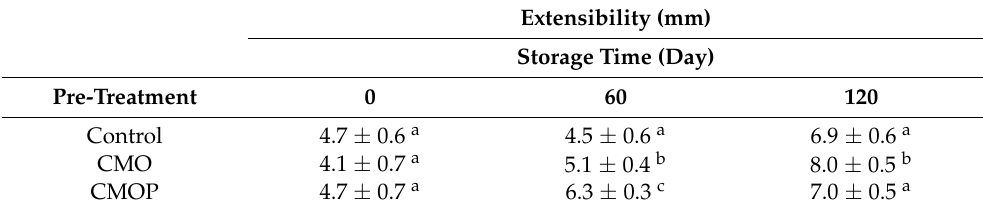
Table 8. Impact of treatment on the extensibility of the dried apple slices *.